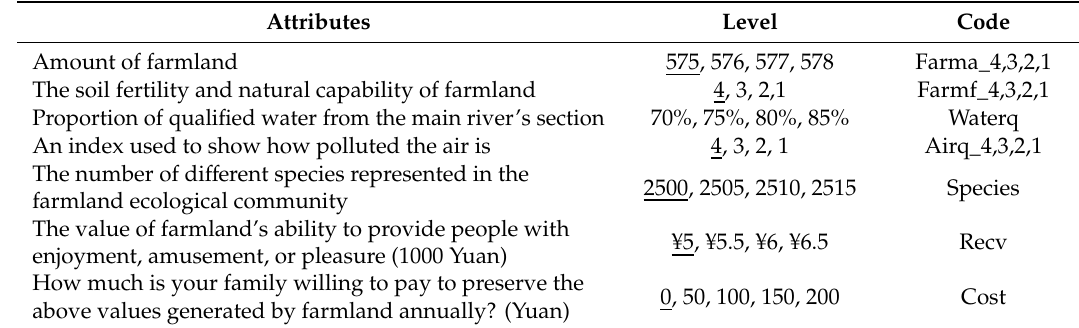
Table 1. The levels of attributes and their codes.